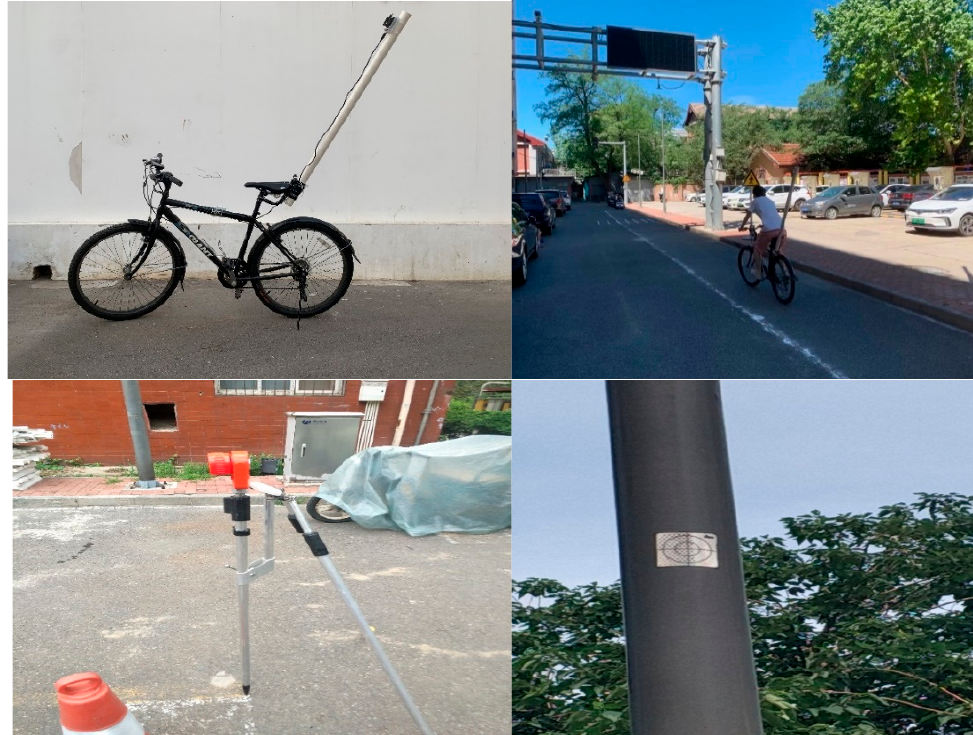
Figure 2. Instrumented bicycle and experimental site setup.